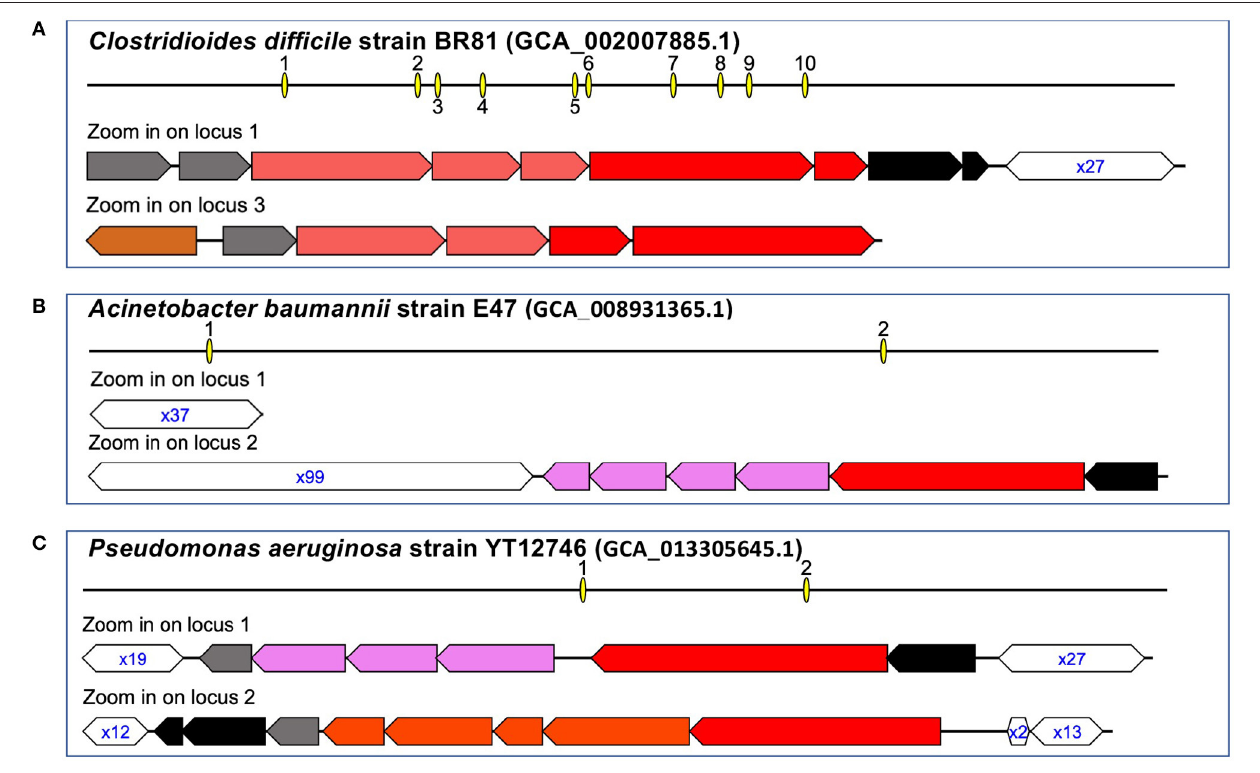
FIGURE 2 | Representative CRISPR–Cas systems in the pathogens. The arrows represent genes (the annotations of the genes can be found in our website), and the open hexagons represent the CRISPR arrays, with the text inside the hexagons showing the copy number of the repeat found in the corresponding CRISPR, e.g., x27 in (A) indicates the corresponding array contains 27 copies of the repeat (spanning 26 spacers). Interactive visualizations of the representative CRISPR–Cas systems with detailed information of the cas genes and the organization of the repeat-spacer units in the CRISPRs are available at the supplementary website. Here we show